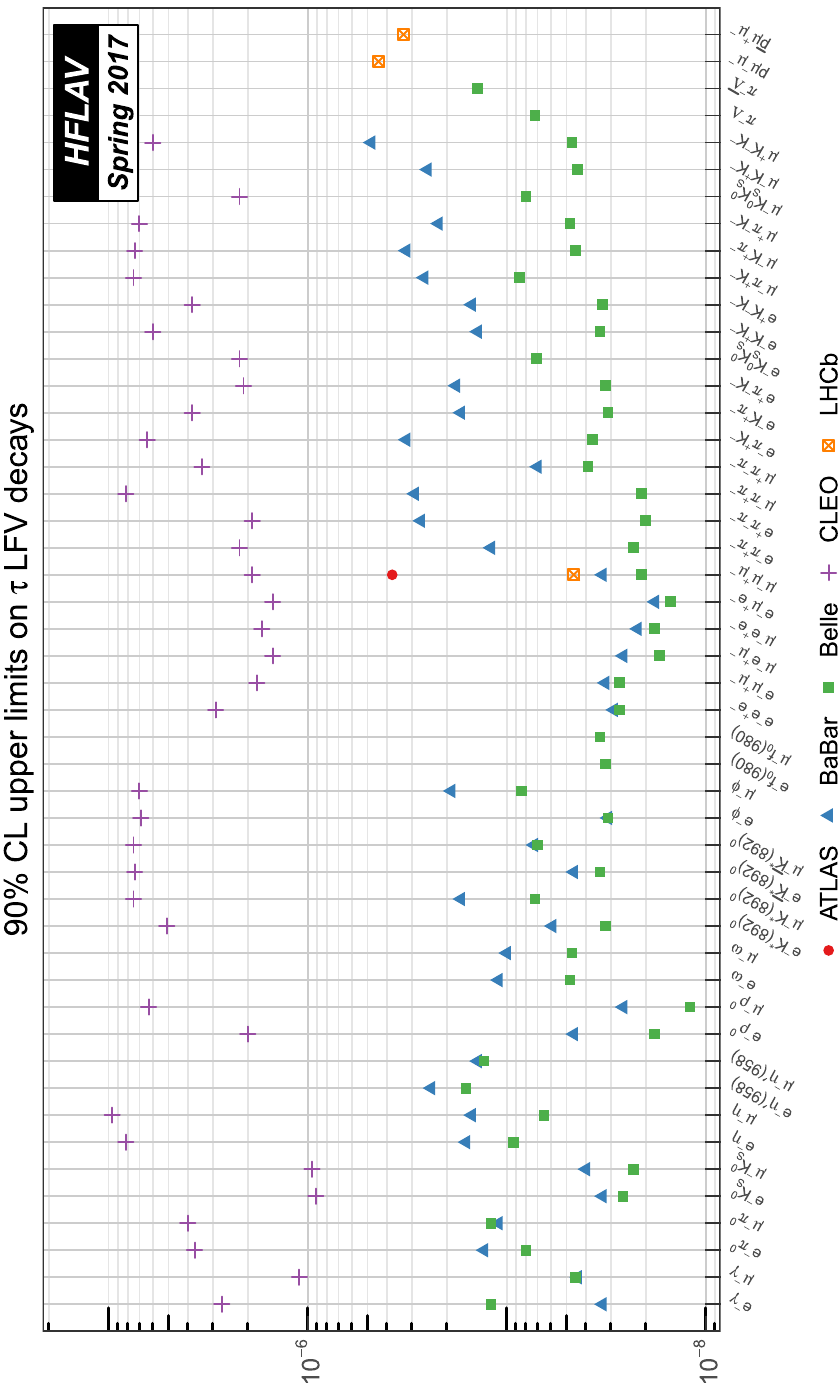
Fig. 221 Tau lepton-flavor-violating branching fraction upper limits summary plot. In order to appreciate the physics reach improvement over time, the plot includes also the CLEO upper limits reported by PDG 2016